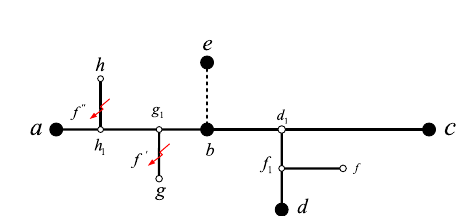
Fig. 5 Schematic diagram of a simple distribution network with overhead line-cable hybrid structure after optimal